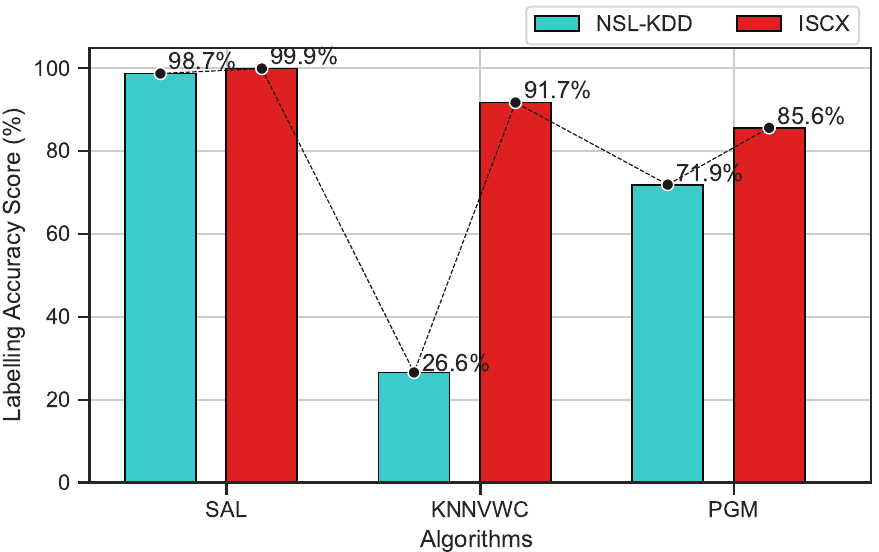
Figure 6. Overall accuracy comparison of semi-supervised algorithms on both